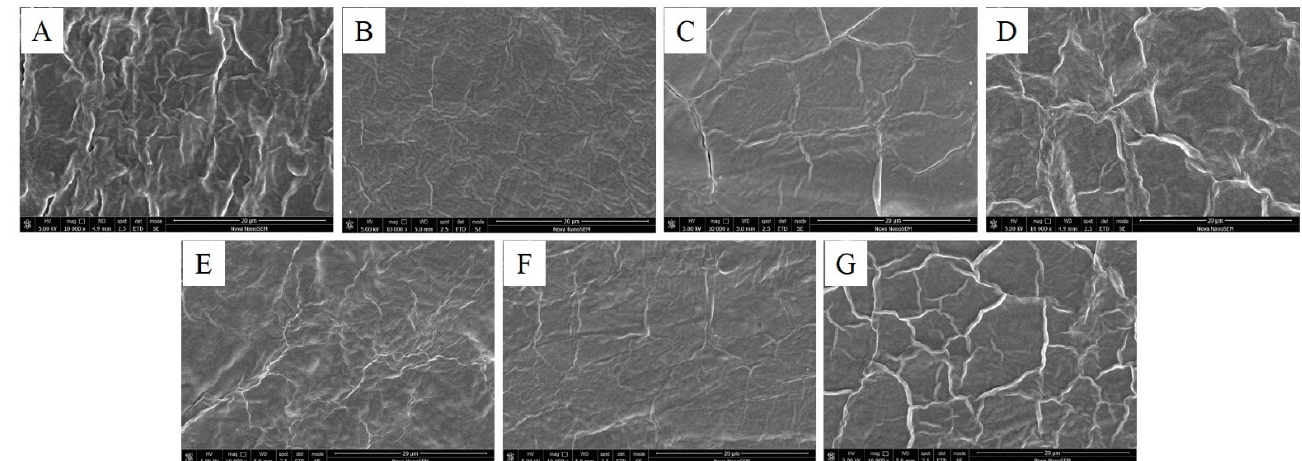
Figure 2. Surface SEM images of the heat pressed films ( A – G ).